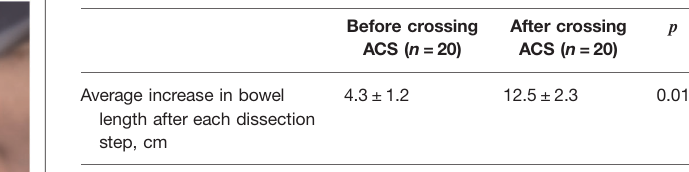
TABLE 1 | Increase in the length of the colon after each step of